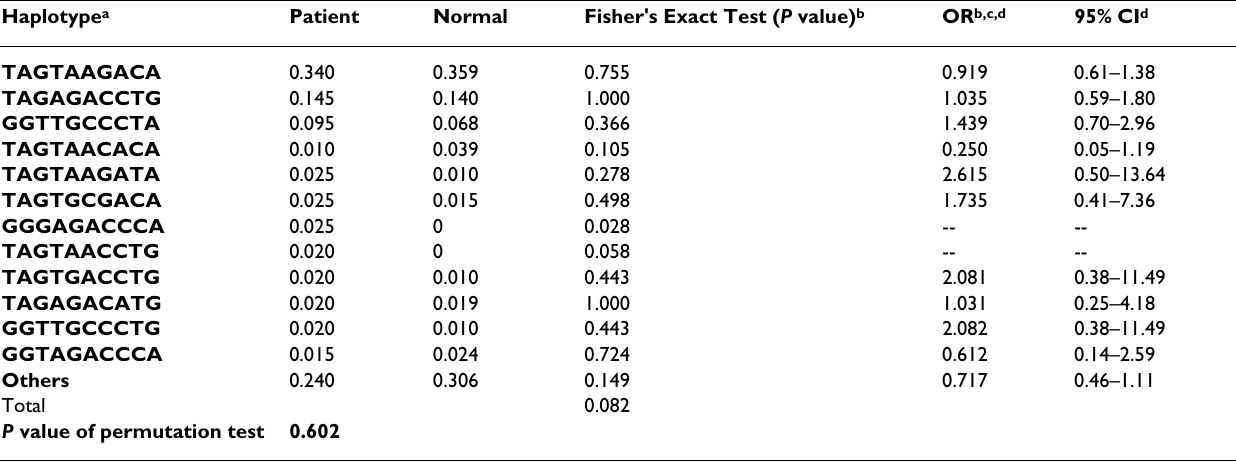
Table 4: Haplotype frequency estimation and test statistics between case and